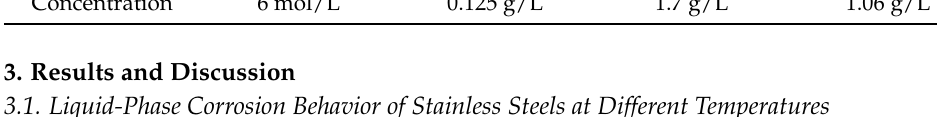
Table 2. Composition of the testing solution used in this work. Composition HNO 3